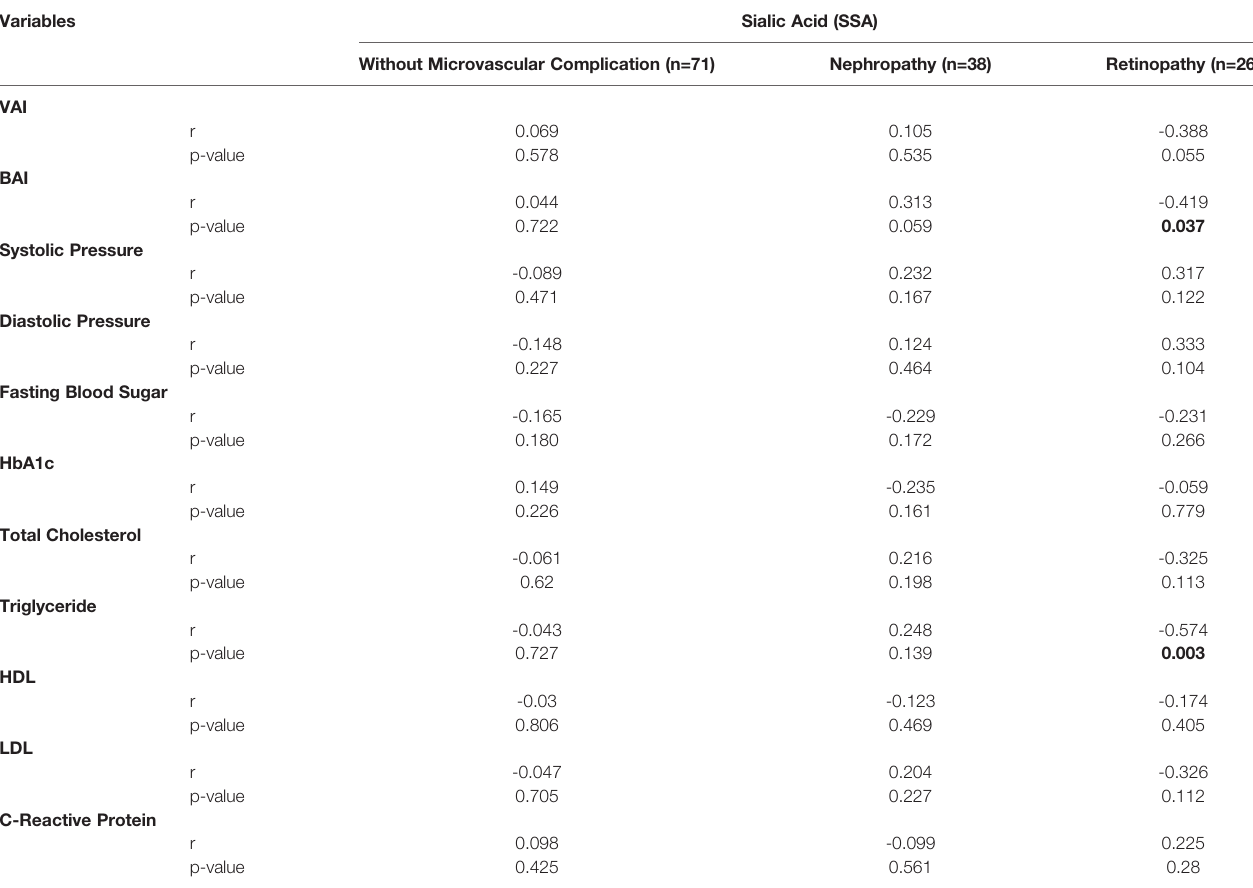
TABLE 3 | Partial correlation between sialic acid and metabolic risk factors among T2D with retinopathy, nephropathy, and those without microvascular complication controlling for age. Variables